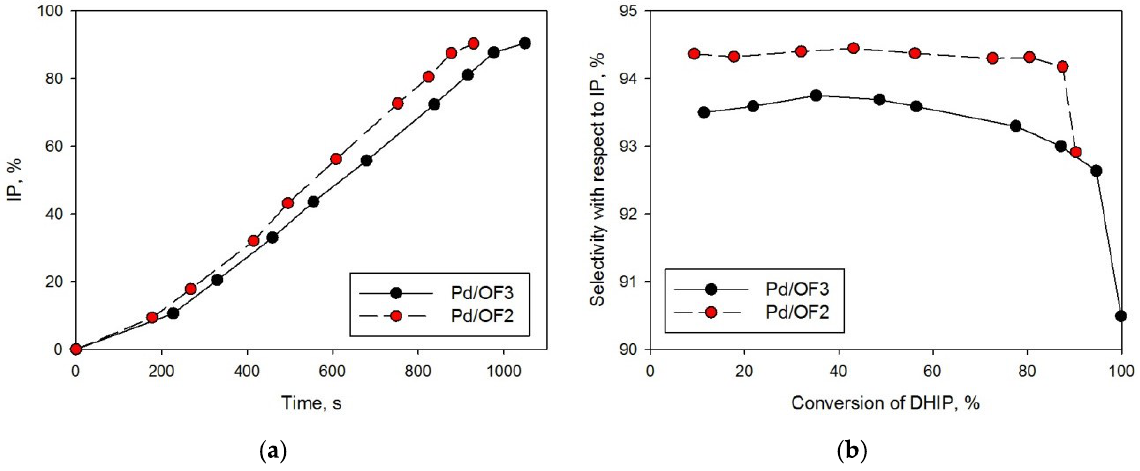
Figure 10. Kinetic curves of IP accumulation ( a ) and dependence of the selectivity, in respect to IP on DHIP conversion of ( b